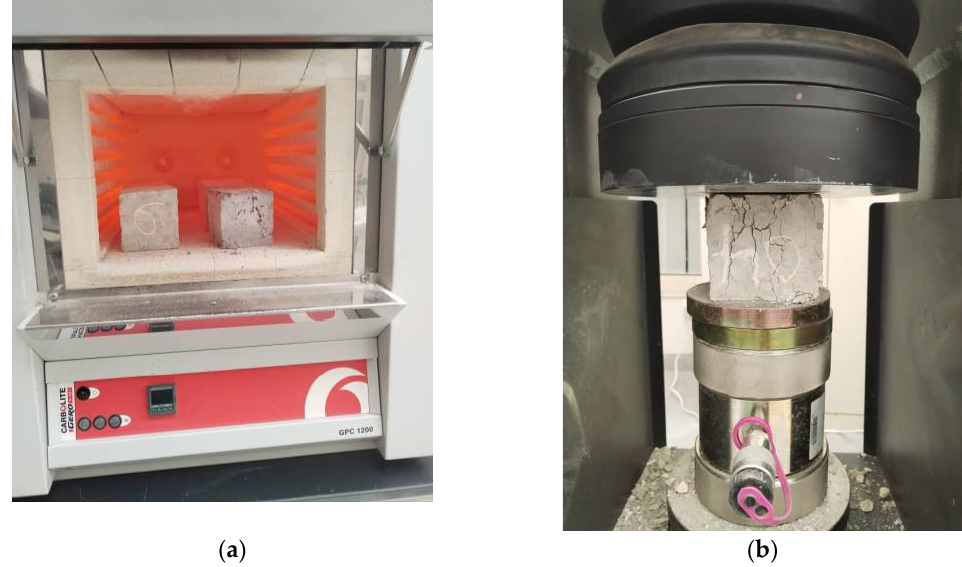
Figure 2. Experimental testing. ( a ) Heating samples furnace at 800 °C; ( b ) compressive strength testing after heating.